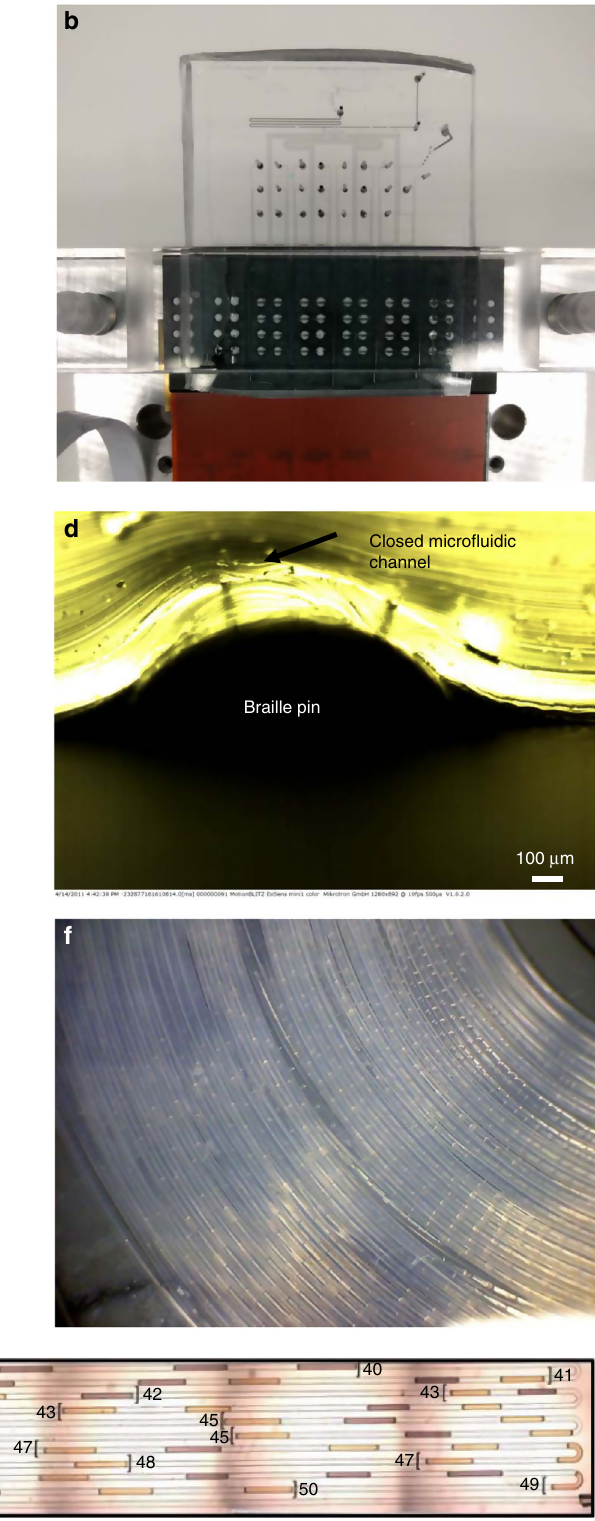
using photomultiplier tubes (PMTs). To demonstrate the power of our barcoding approach, we converted a simpli fi ed EMBL logo (Supplementary Fig. 5) into a binary black and white image and translated all 2808 pixels into a sequence of plugs with two different fl uorescence intensities. These barcodes were